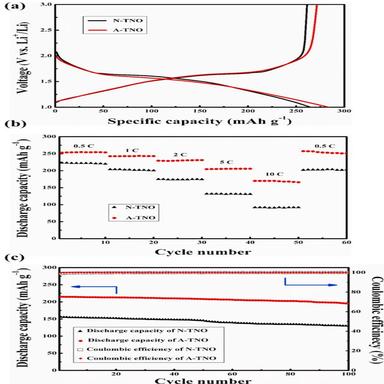
(a) Discharge-charge curves at 0.1 C of first cycle, (b) rate capabilities under various current rates, and (c) cycling performance at 5 C of TiNb2O7 samples synthesized via both the solid-state method and the agarassisted method.